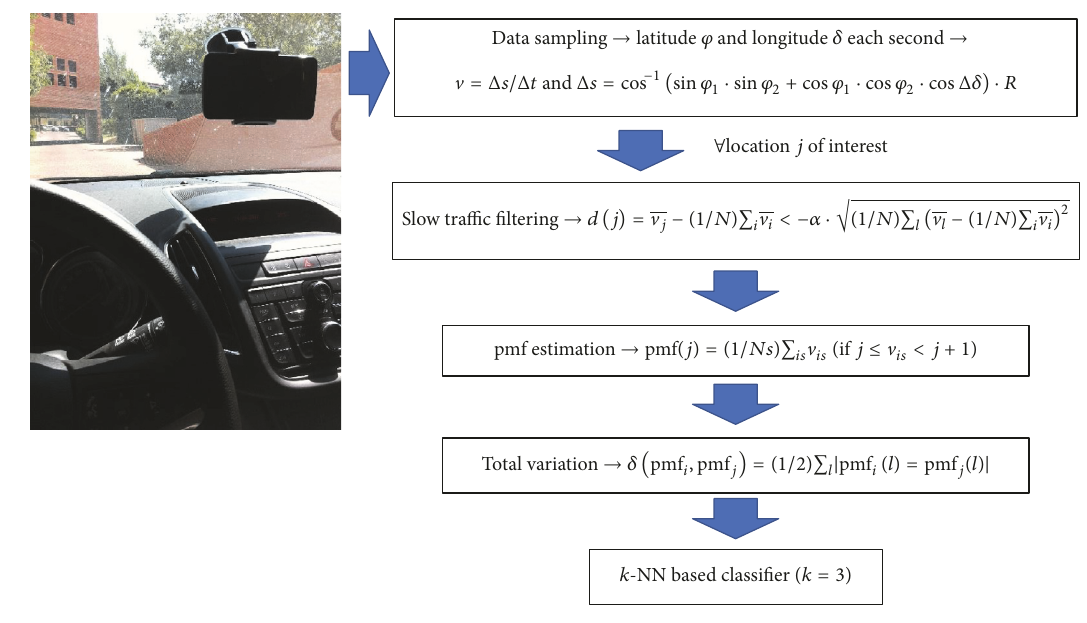
Figure 1: Flowchart of the proposed